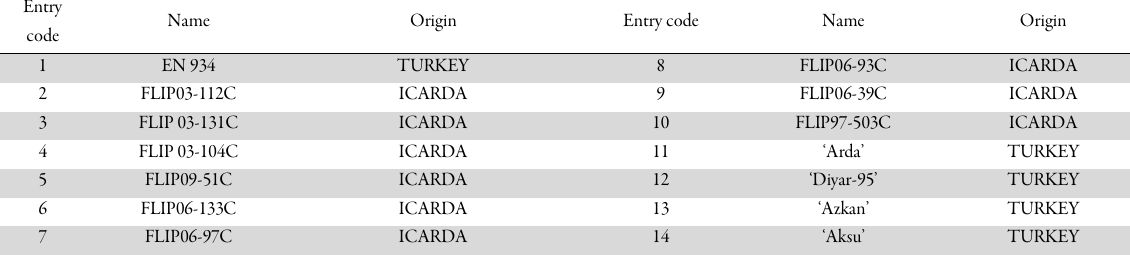
Table 1. List of the 14 chickpea genotypes used for the